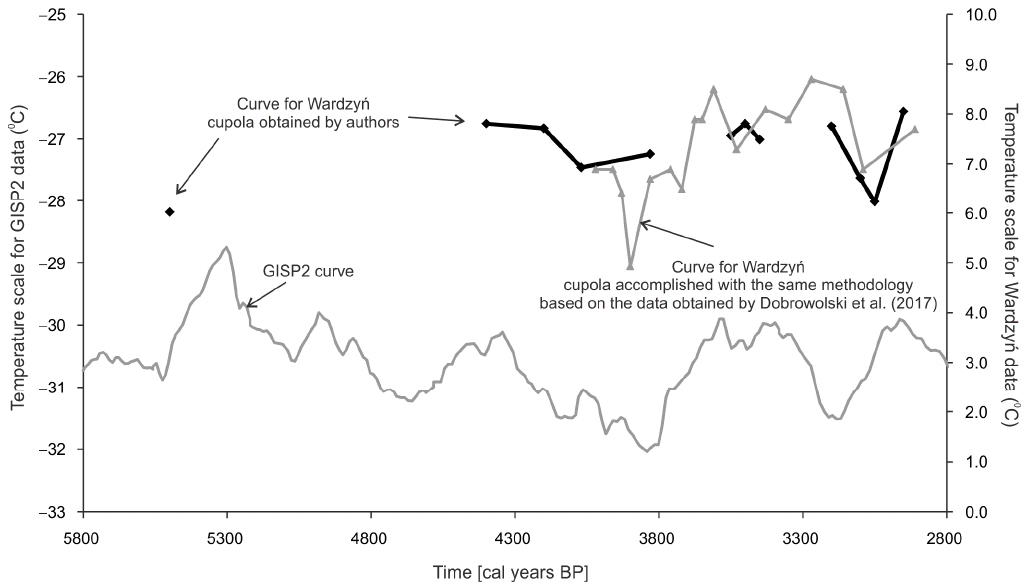
Figure6. ComparisonoftheGISP2curvewithtemperaturesbasedonstableoxygenisotopesfromcalcareous Figure 6. Comparison of the GISP2 curve with temperatures based on stable oxygen isotopes from tufa samples from Wardzy´n. The figure presents also temperatures obtained by Dobrowolski et al. [5] calcareous tufa samples from Wardzy ń . The figure presents also temperatures obtained by based on δ 18 O from the neighbouring core in the same Dobrowolski et al. [5] based on δ 18 O from the neighbouring core in the same cupola.